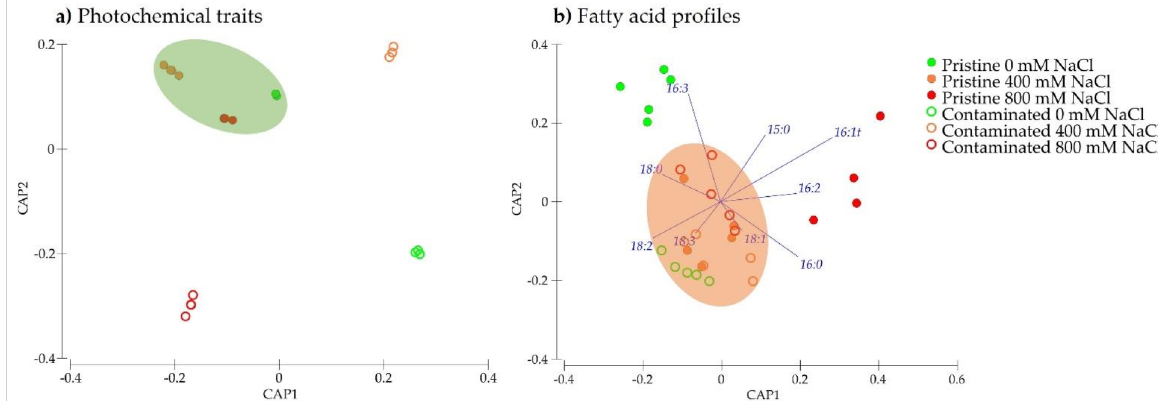
Figure 9. Canonical analysis of principal coordinates (CAP) based on ( a ) photochemical traits and ( b ) based on the fatty acid profiles, pentadecanoic acid (C15:0), palmitic acid (C16:0), trans-delta 3-hexadecenoic acid (C16:1t), hexadecatrienoic acid (C16:3), stearic acid (C18:0), oleic acid (C18:1), linoleic acid (C18:2) and linolenic acid (C18:3)) from S. patens collected in pristine and heavy metal contaminated salt marshes exposed to the tested NaCl